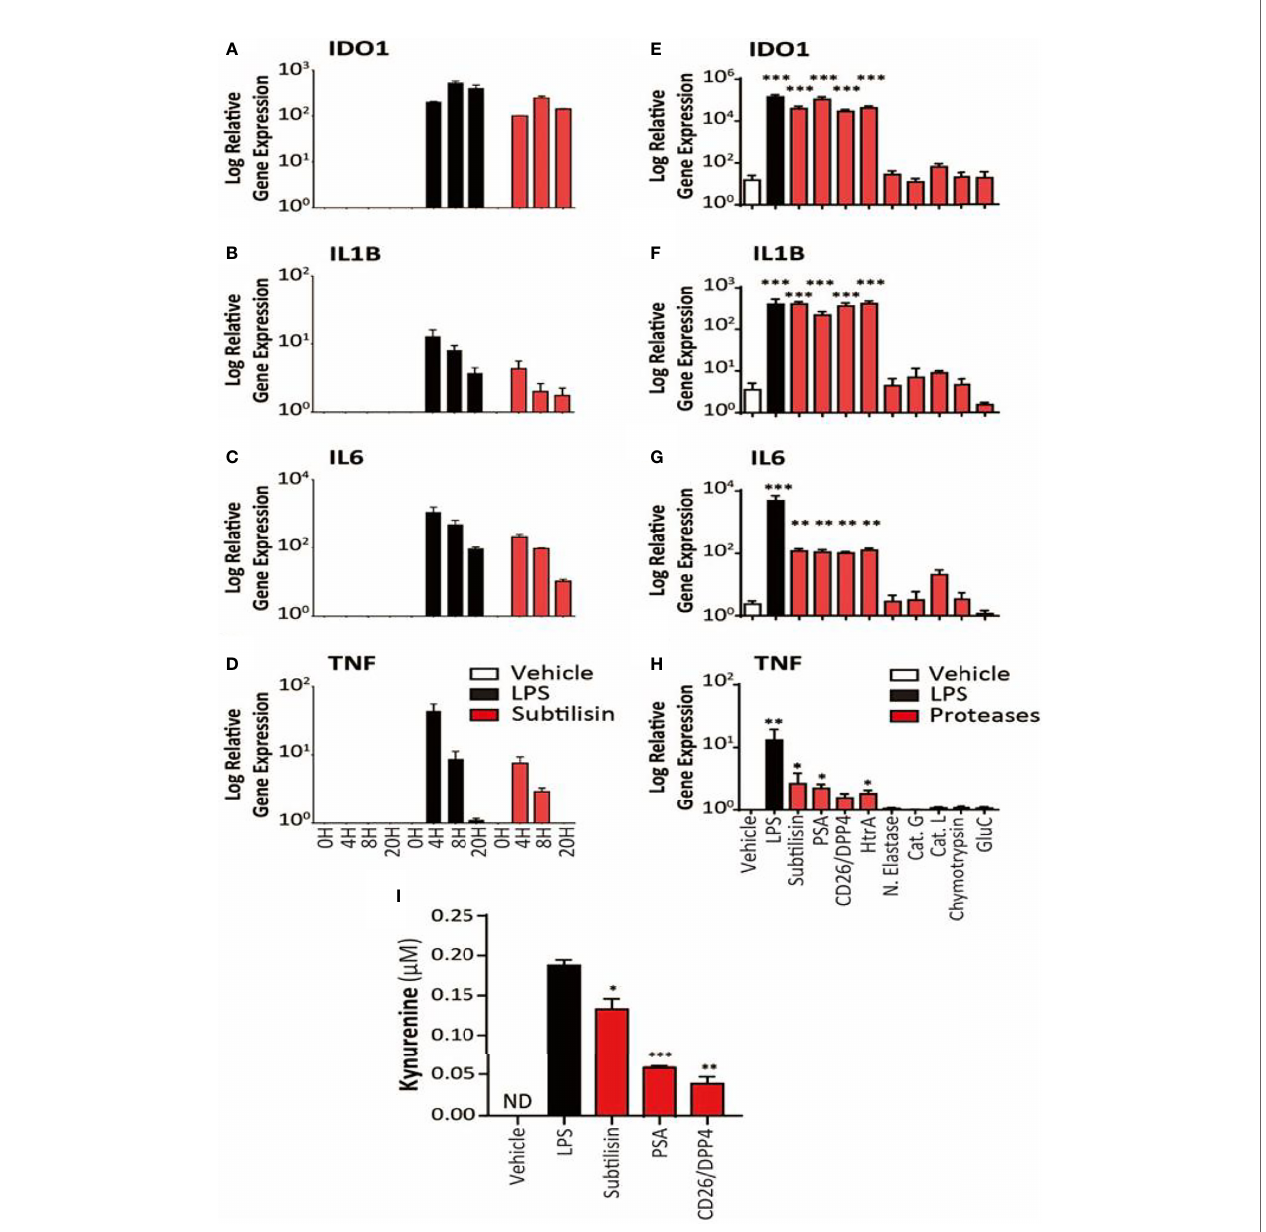
FIGURE 2 | Time course and activity of serine proteases on human MDMs. The left-side panels (logarithmic scales) illustrate (A) the apparent maximal induction of IDO1 after 8 h incubation with LPS (10 ng/mL) or subtilisin (20 nM); (B) peak induction before 4 h of IL1B and (C) IL6; (D) a relatively rapid induction of TNF expression with a maximum before 4 h declining to baseline by 20 h. The right-side panels indicate the effects of proteases on (E) IDO1 (F) IL1B , (G) IL6 and (H) TNF expression by vehicle, LPS (10 ng/mL), subtilisin (20 nM), PSA (100 nM), CD26/DPP4 (10 nM), HtrA (10 nM), neutrophil elastase (25 m g/mL), cathepsin G (25 m g/mL), cathepsin L (25 m g/mL), chymotrypsin (25 m g/mL) and glu-C (10 nM). Panel (I) shows the concentration of kynurenine in the culture supernatant of cells exposed to LPS, subtilisin, PSA and CD26/DPP4. Charts show the mean ± s.e.m. (n ≧ 3 donors). The number of experiments (n) was 3 (for A-D) or n ≧ 3 (for E-I). *P < 0.05, **P < 0.01; ***P <